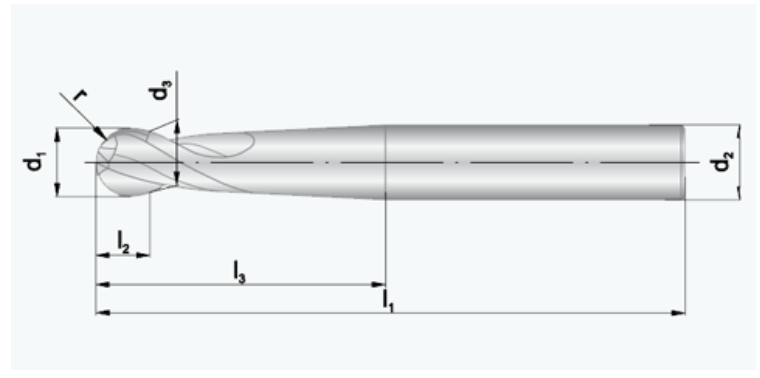
Figure 1. Ball end milling cutter used in processing (Perschmann 2020).